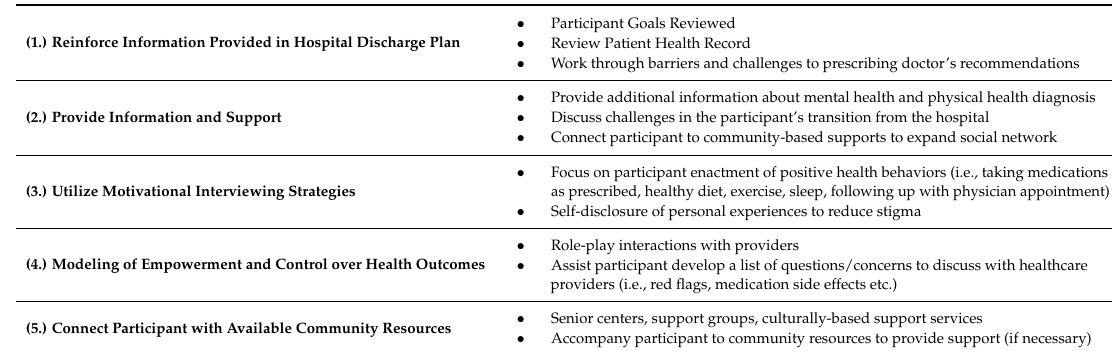
Table 2. Peer Support Intervention